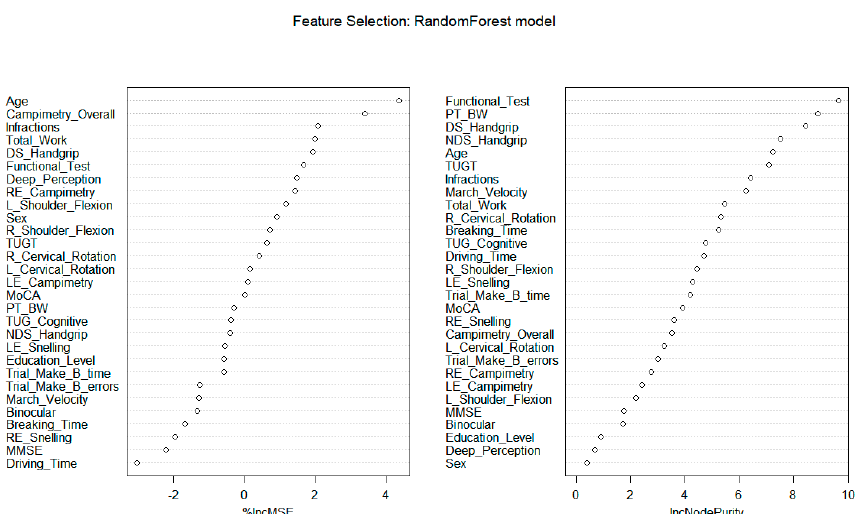
Figure 2. Importance of the variables to predict road crash through the Random Forest model.